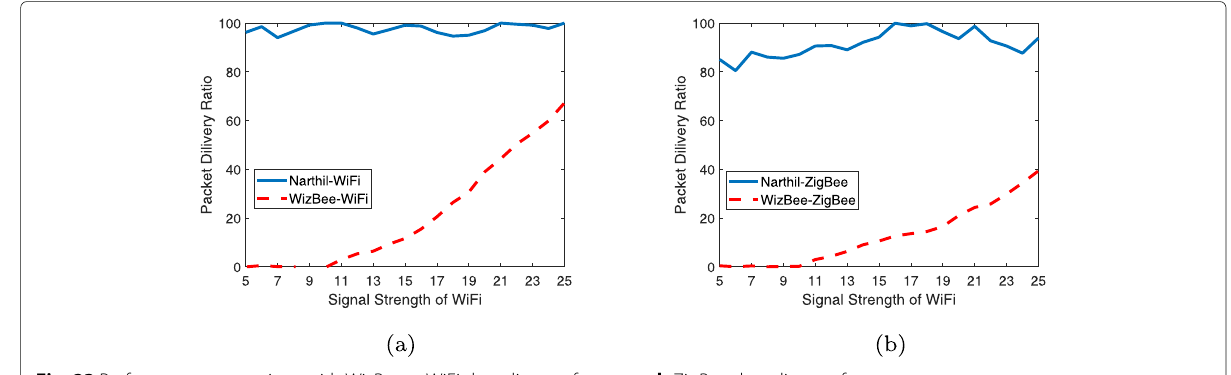
Fig. 23 Performance comparison with WizBee. a WiFi decoding performance. b ZigBee decoding